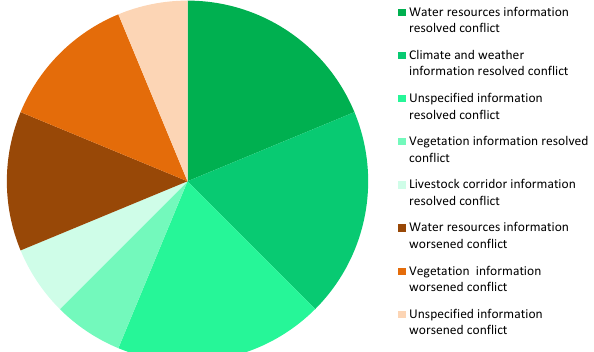
Figure 1. Distribution of 16 responses on which type of informa- tion may lead to conflict resolution or aggravation as experienced by staff from provincial, agricultural, and meteorological services, and also from radio stations in Burkina Faso, Mali, and Niger. Thir- teen respondents provided answers; three provided information on two information categories. Source: questionnaire distributed at the workshop on the dissemination of agro-hydro-climatological infor- mation to final users, 3–4 December 2015, for the project: Knowl- edge Based Climate Adaptation in West